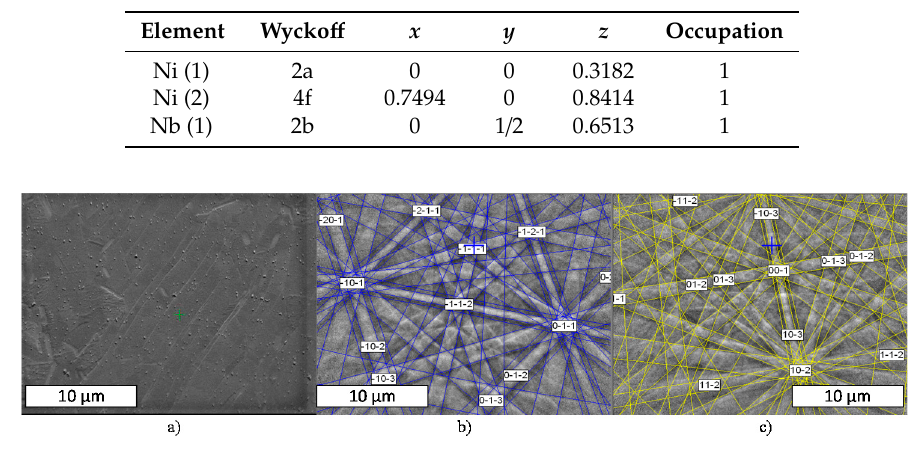
Figure 8. Backscattered electron Kikuchi patterns (EBSKP) indexing of Sample B. ( a ) SEM image; ( b , c ) nickel γ -phase (blue) and δ -phase (yellow) EBSKP overlay, respectively.